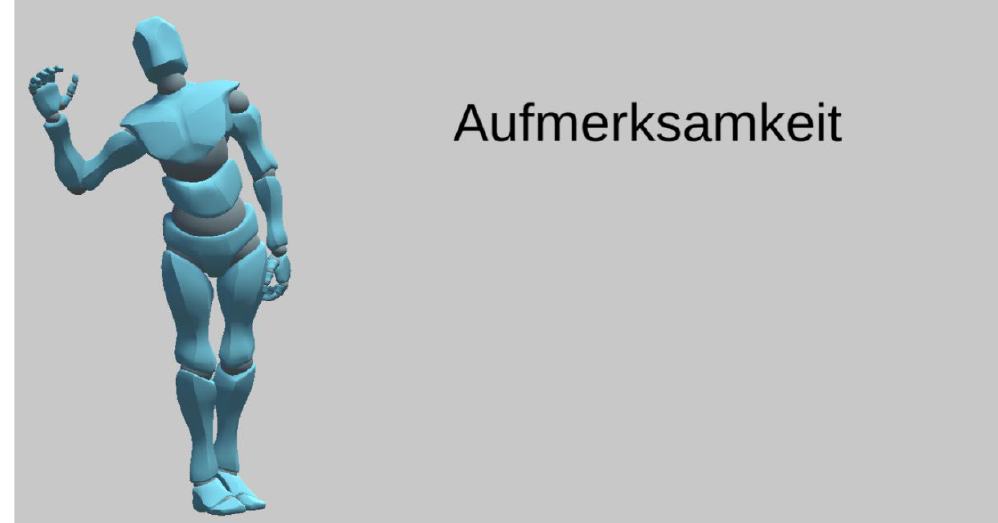
Figure 5. Screenshot of the reference implementation’s lesson player. A robot-like avatar enacted the gesture, while the learning content was displayed in text and spoken out loud by the text-to-speech engine.